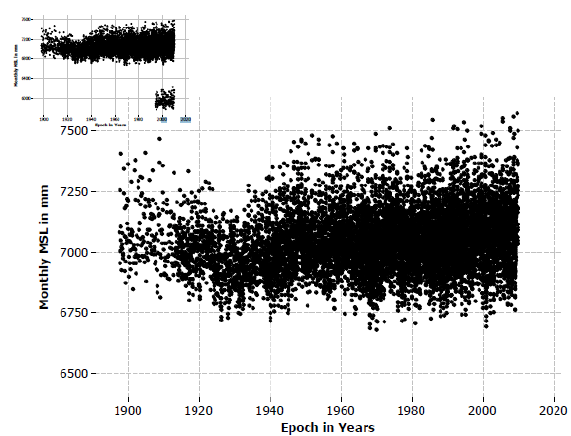
Figure 5. Combined monthly MSL data from 26 tide gauge sta- tions. The revised local reference data still exhibit refer- ence level differences despite the preliminary adjustments by the PSMSL. However the differences are small except one; Virginia tide gauge stations whose data are displayed in the